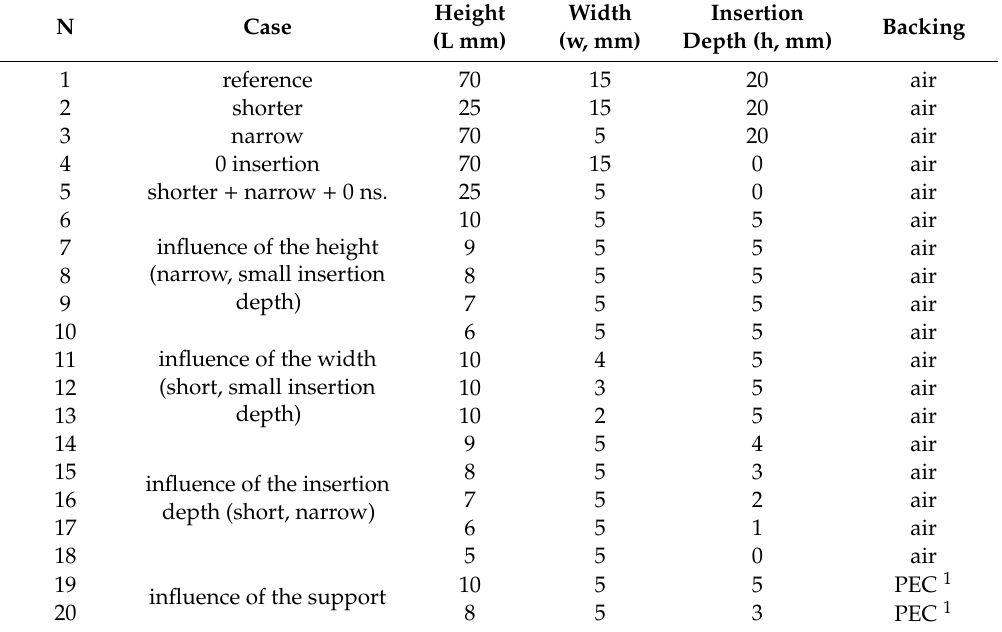
Table 1. Cases considered in the sensitivity